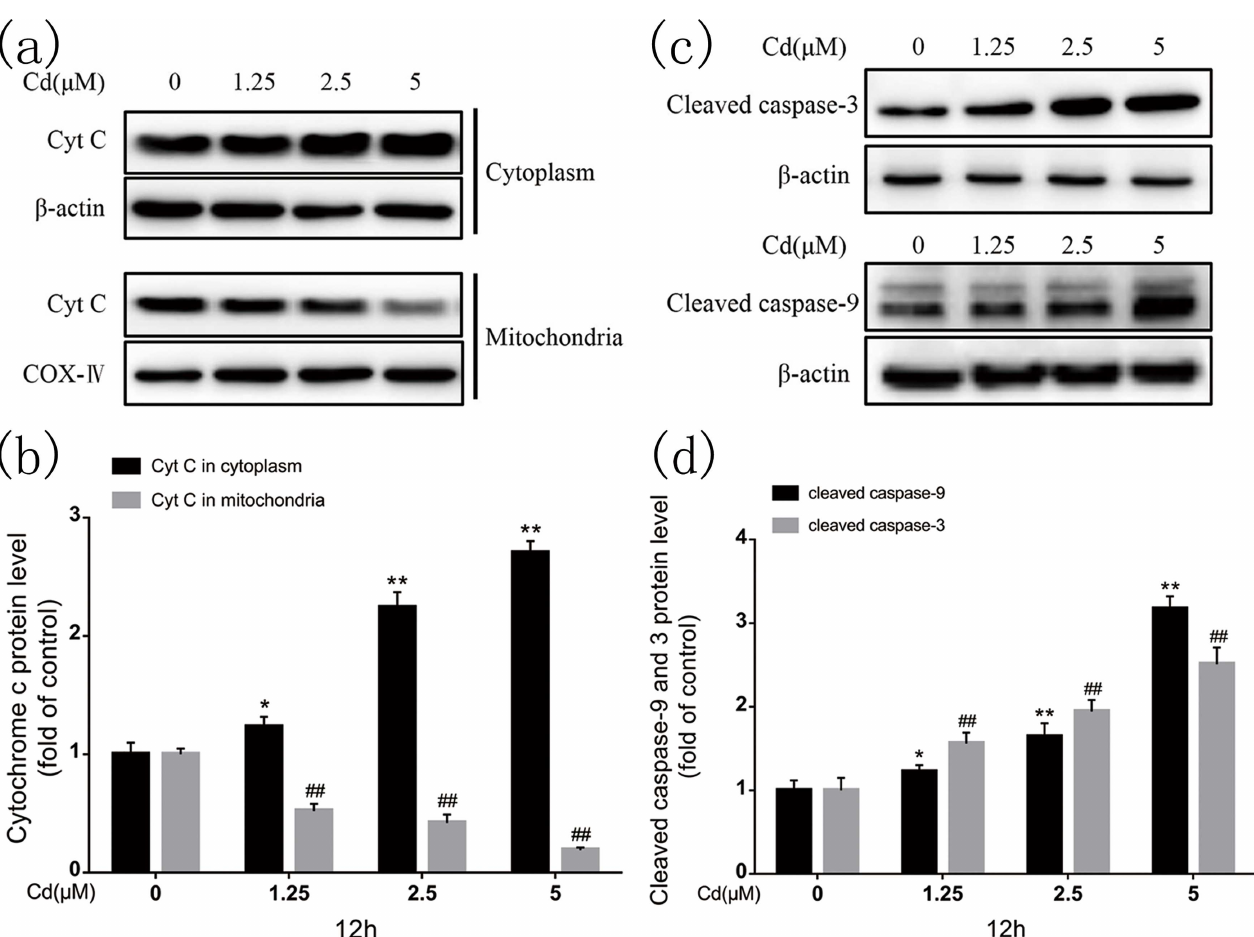
Fig 3. Cadmium induced mitochondrial cyt c releaseto the cytoplasm and subsequent caspase-9 and caspase-3 activation in rPT cells. (a, c) Representative western blots of cyt c, cleavedcaspase-9,and cleavedcaspase-3.(b, d) Quantitative analysisof cyt c, cleavedcaspase-9, and cleavedcaspase-3western blots; grayscaleof the control was set at 1. Quantitative analysiswas performed with images from three independentexperiments (mean ± SD, n = 3). * P < 0.05, ** P < 0.01, and ## P < 0.01 as compared to